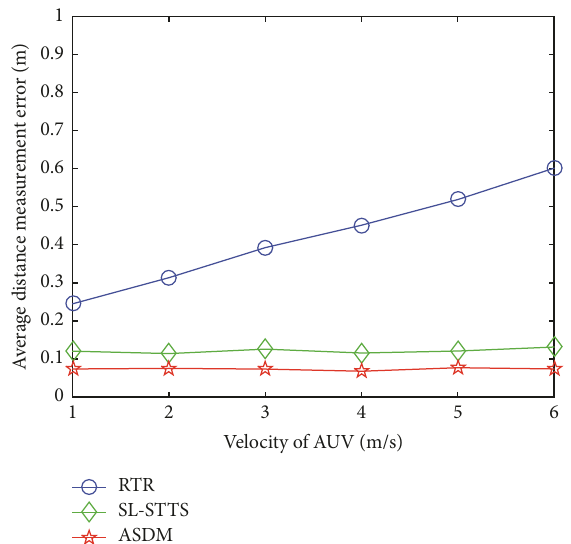
Figure 4: Average distance measurement error versus velocity of